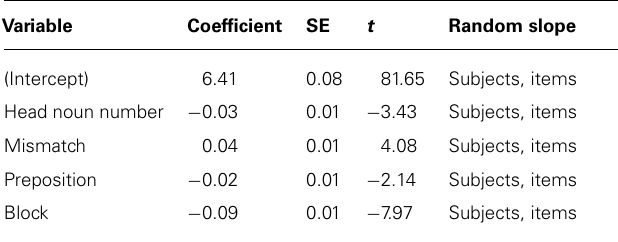
Table 6 | Logistic mixed-effects model predicting response times in Experiment